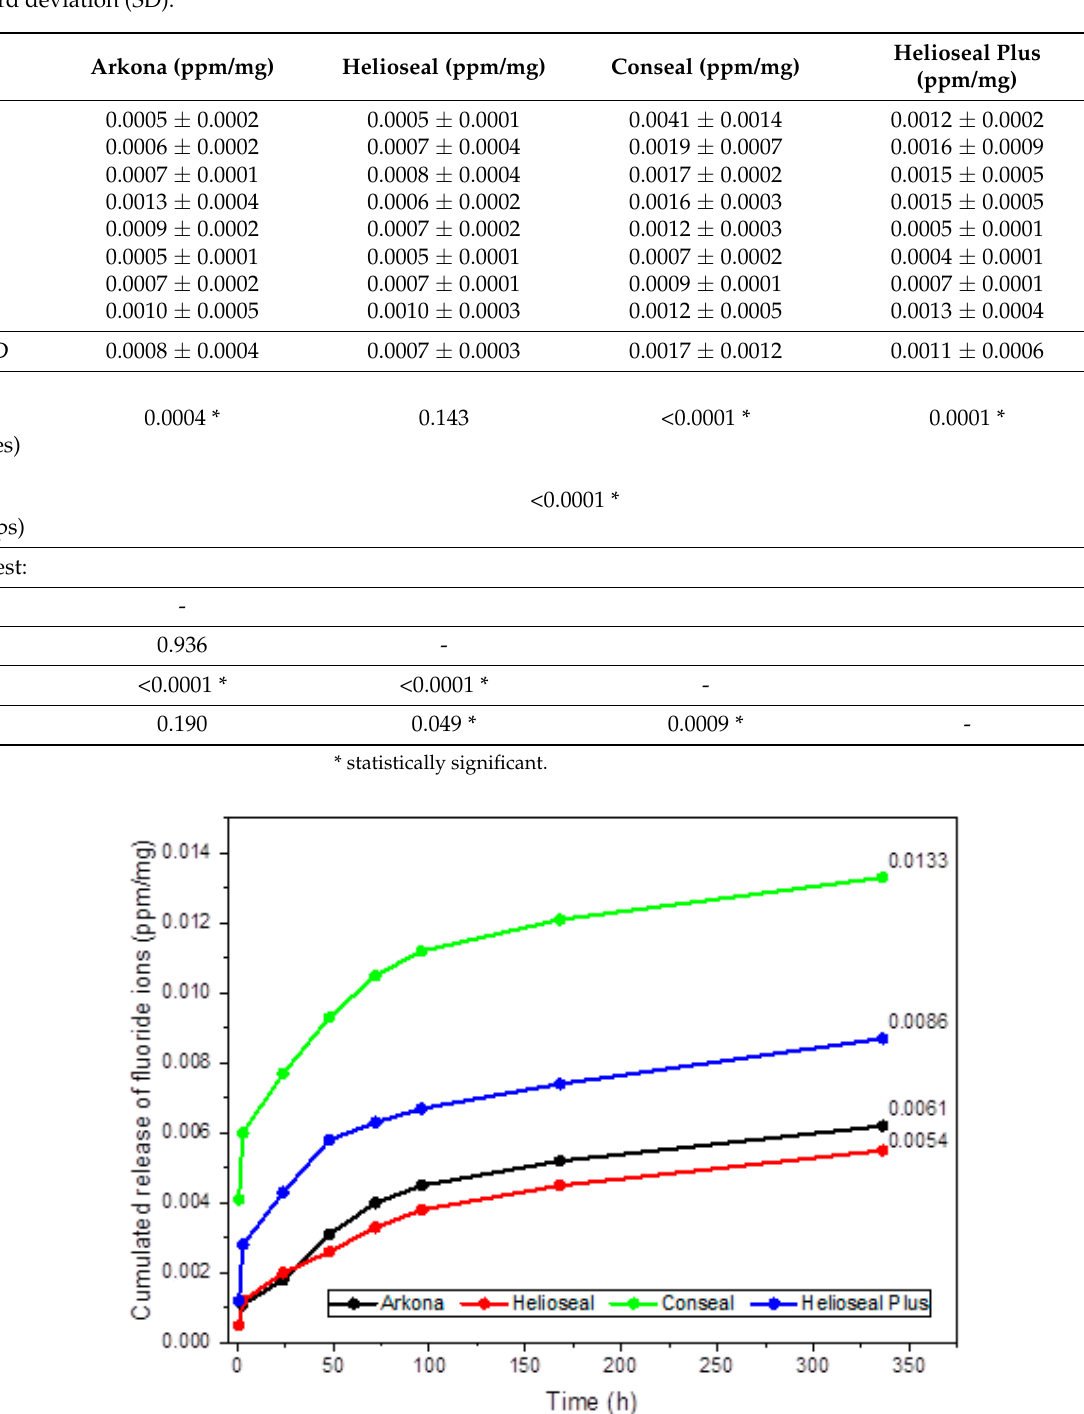
Table 2. Fluoride ion release (ppm/mg) from fissure sealants into deionized water. Descriptive data are presented as mean values + standard deviation (SD).